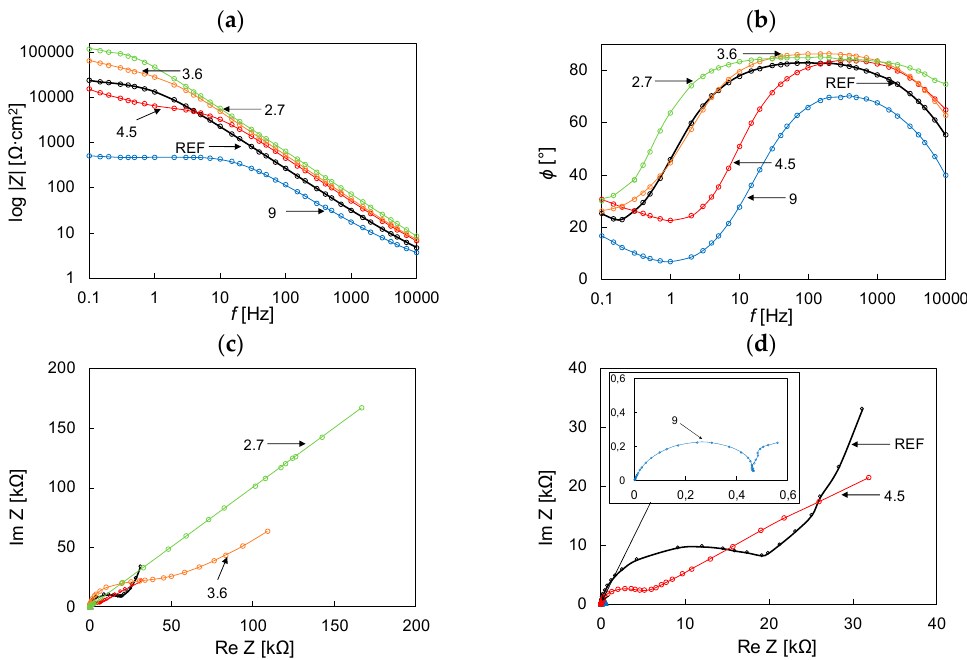
Figure 5. Electrochemical Impedance Spectroscopy EIS data obtained in 3.5% NaCl solution for the reference and laser-treated samples, including ( a ) Bode plots-impedance, ( b ) Bode plots-phase angle, and ( c ) Nyquist plots ( d ) enlarging the Nyquist plot fragment.